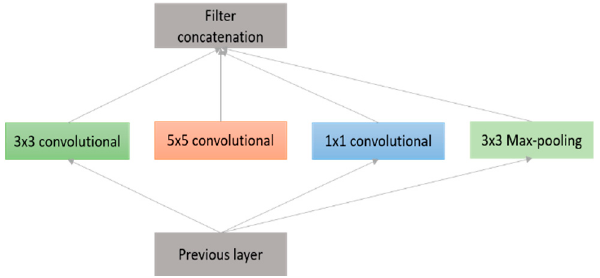
Figure 14. Inception layer: Naive version.